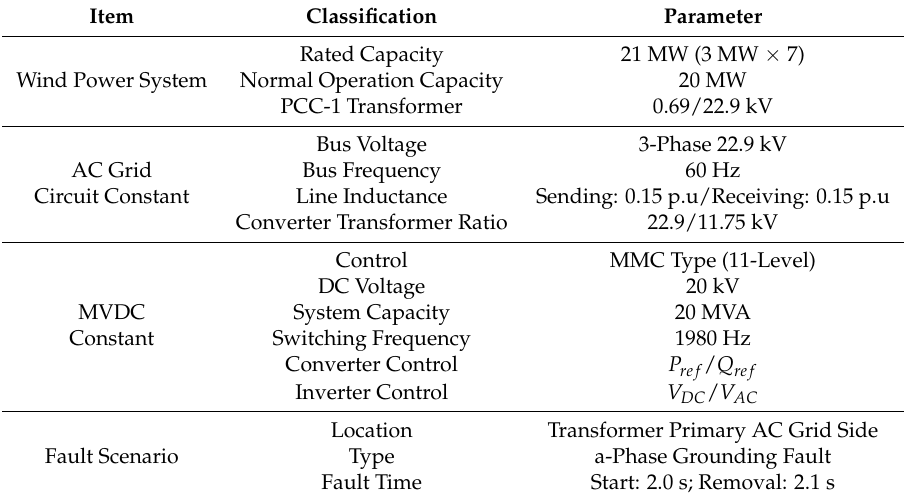
Table A2. The MVDC parameters for the offshore wind